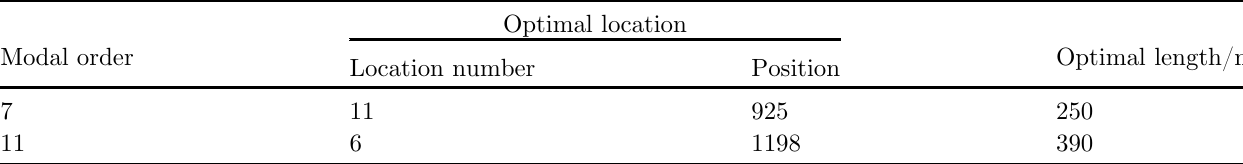
Table 1. Optical fi ber sensor optimization result.